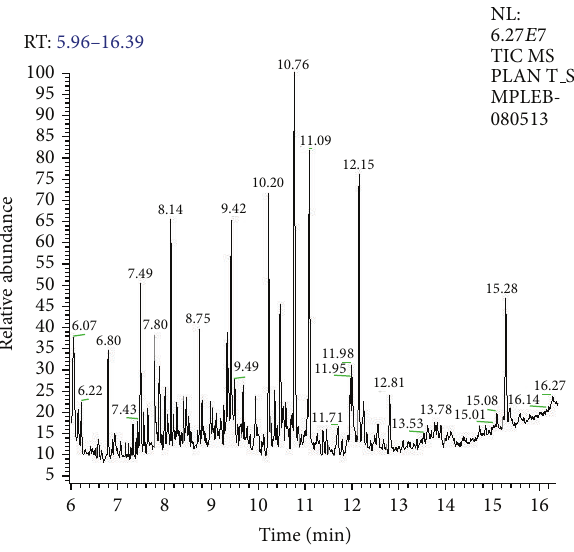
Figure 1: GC chromatogram of the leaf extract (acetone) of Centella asiatica